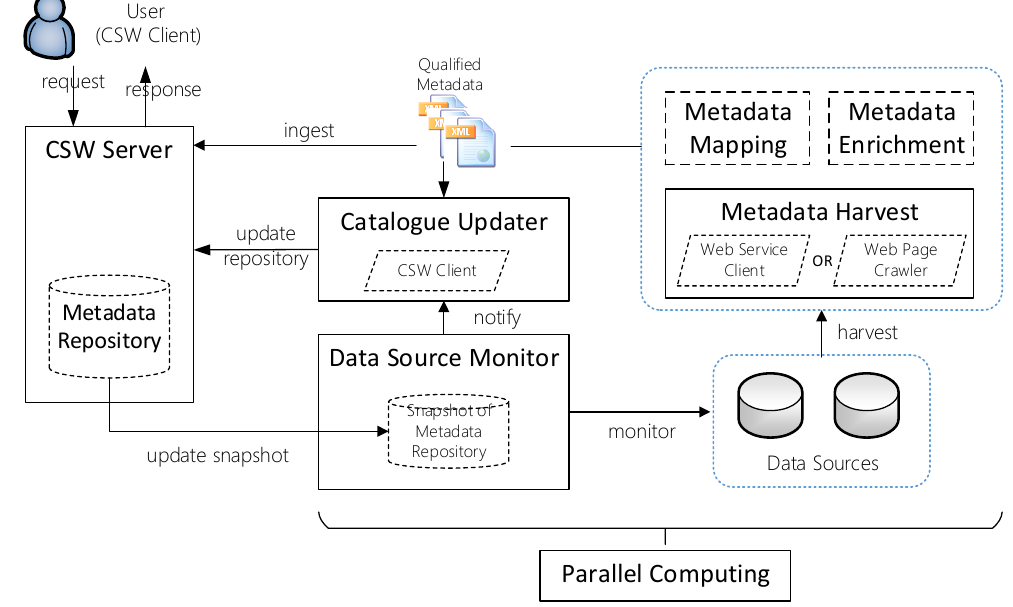
Figure 1. Framework of the near-real-time OGC catalogue service.